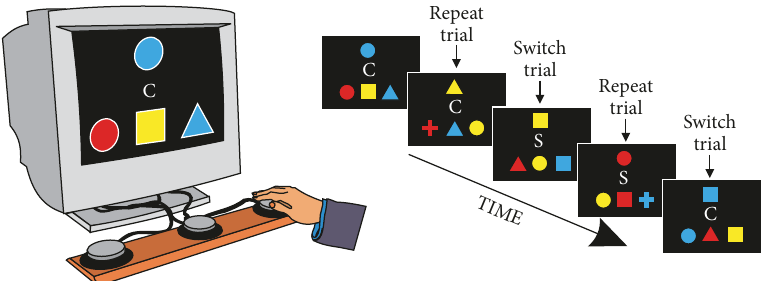
Figure 1: Illustration of the experimental apparatus and task conditions for the task switching test. Participants were instructed to match the top shape with one of the bottom three shapes. If the letter in the middle was a “C,” then they were to match based on color. If it was an “S,” then they were to match based on shape. [Note that the relative size of the stimuli has been enlarged for illustrative